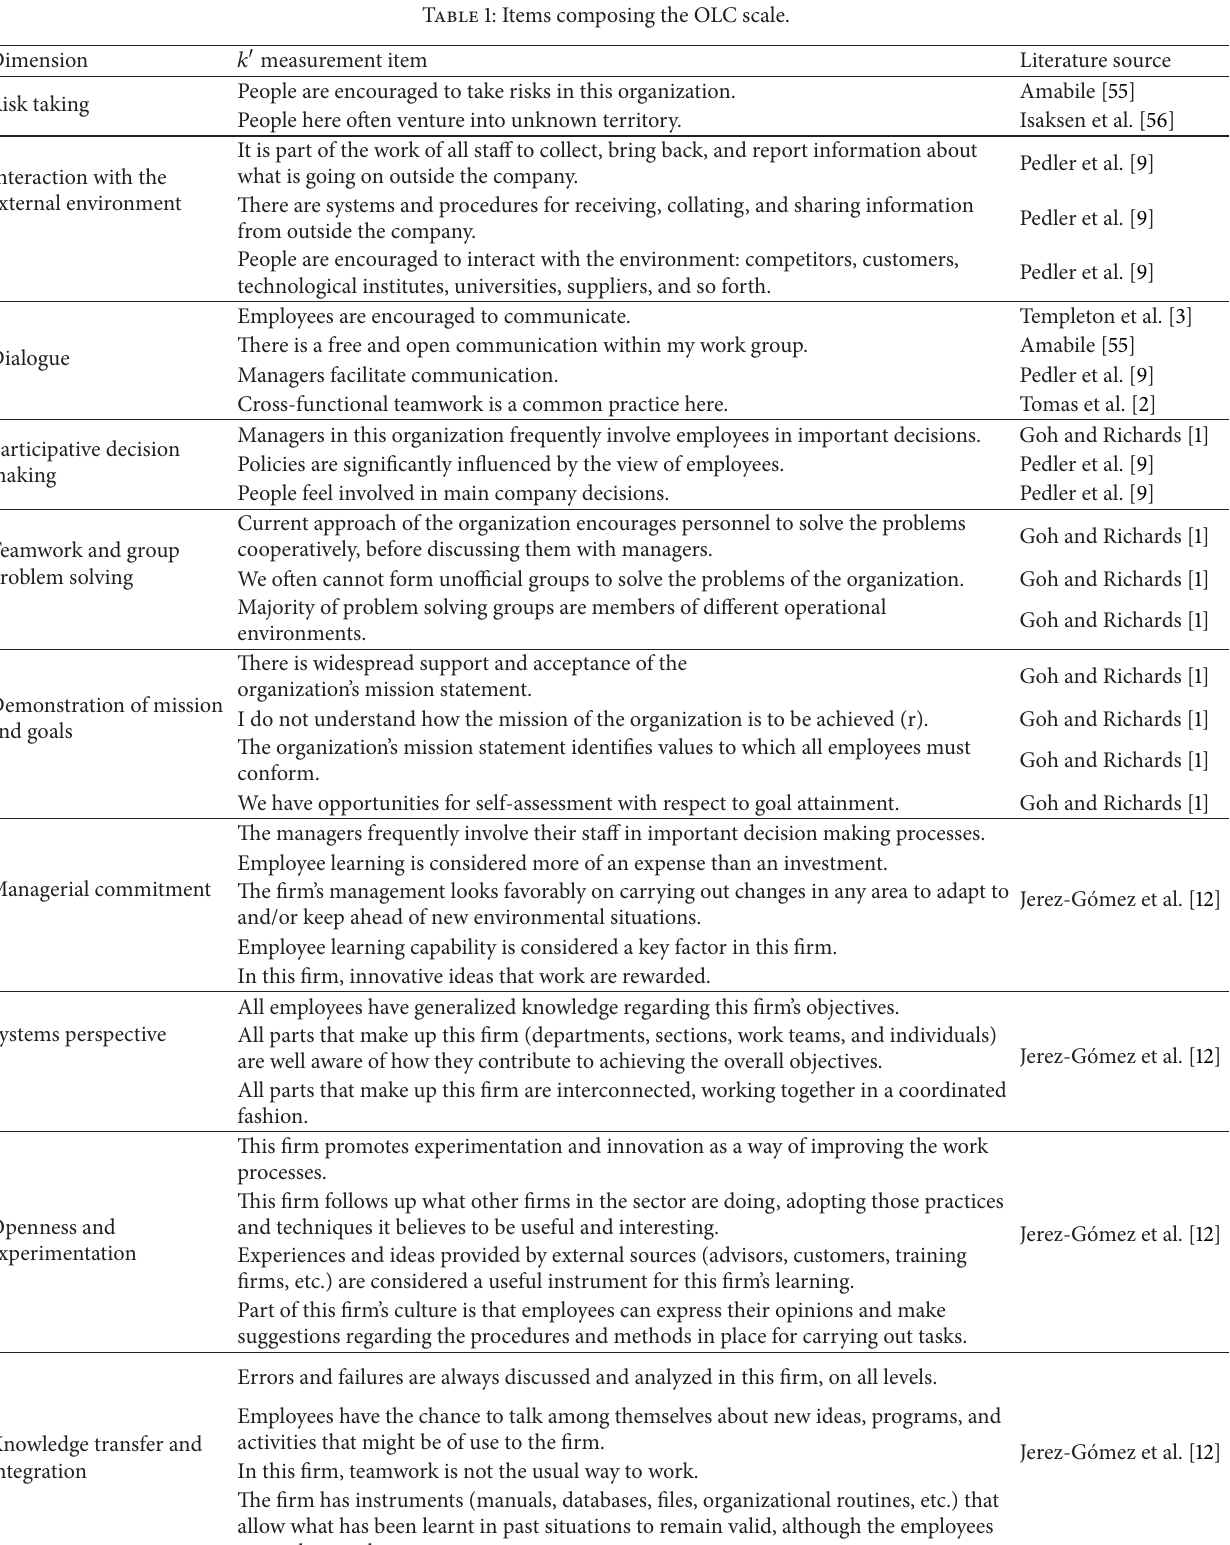
Table 1: Items composing the OLC